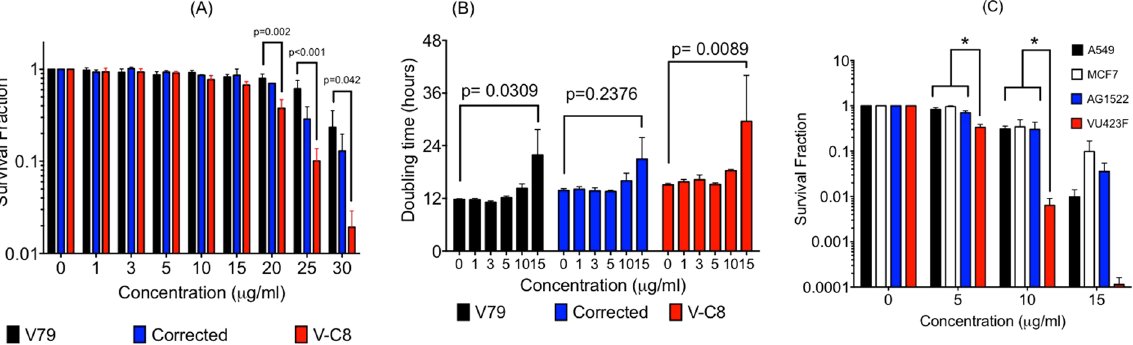
Figure 1. Cytotoxicity to rosemary extract. ( A ) Cell survival fraction obtained by colony formation assay for hamster cells. Black bars indicate V79, blue bars indicate gene corrected V-C8, and red bars indicate V-C8 cells. ( B ) Elongation of cell doubling time with high concentrations of rosemary extract exposure. ( C ) Cell survival fraction obtained by colony formation assay for human cells. Black bars indicate A549, white bars indicate MCF7, blue bars indicate AG1522, and red bars indicate VU423F BRCA2 deficient cells. At least three independent experiments were carried out. Error bars indicate standard error of the mean. P-values represent two-way ANOVA results. * symbols indicate statistical significance (P <